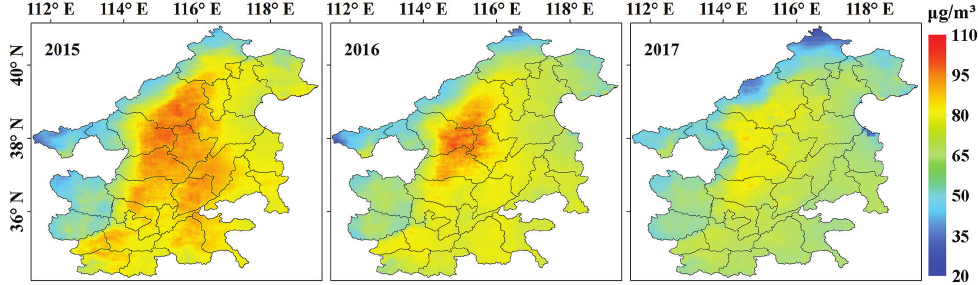
Figure 6. Spatial distribution of AAPC in 2015, 2016, and 2017.